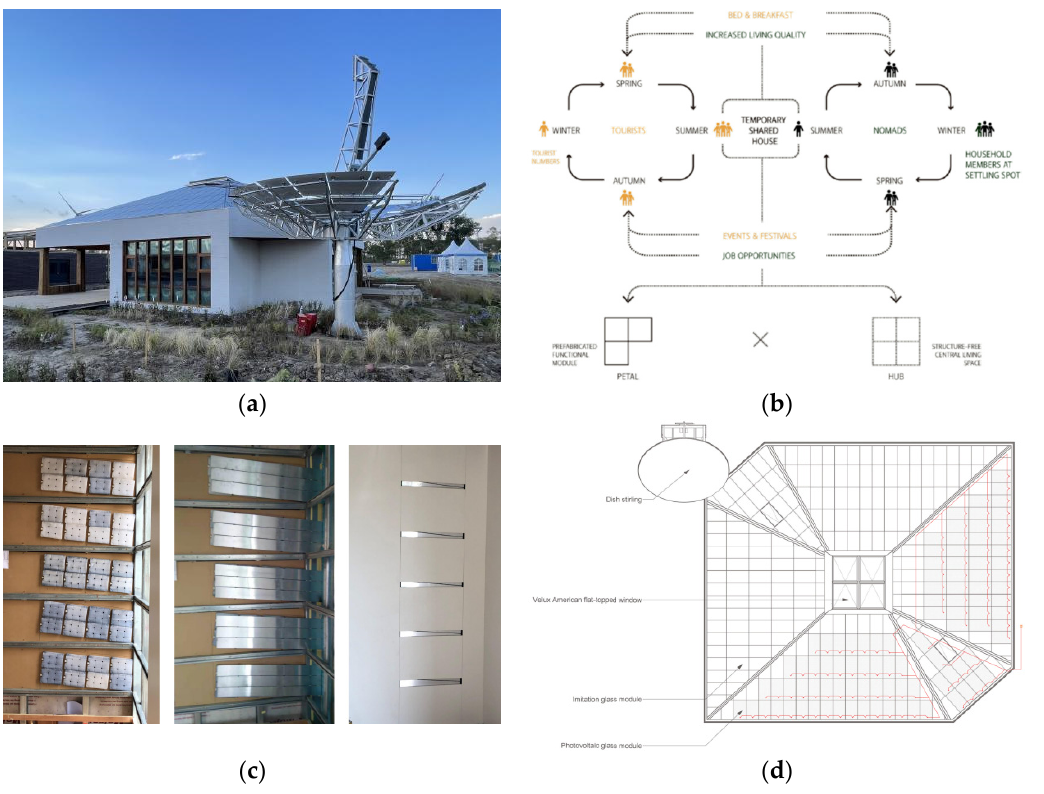
Figure 7. Main results of The Steppe Ark. ( a ) Modern yurt. ( b ) Shared low-carbon life. ( c ) PCM wall. ( d ) PV panels and Stirling engine.